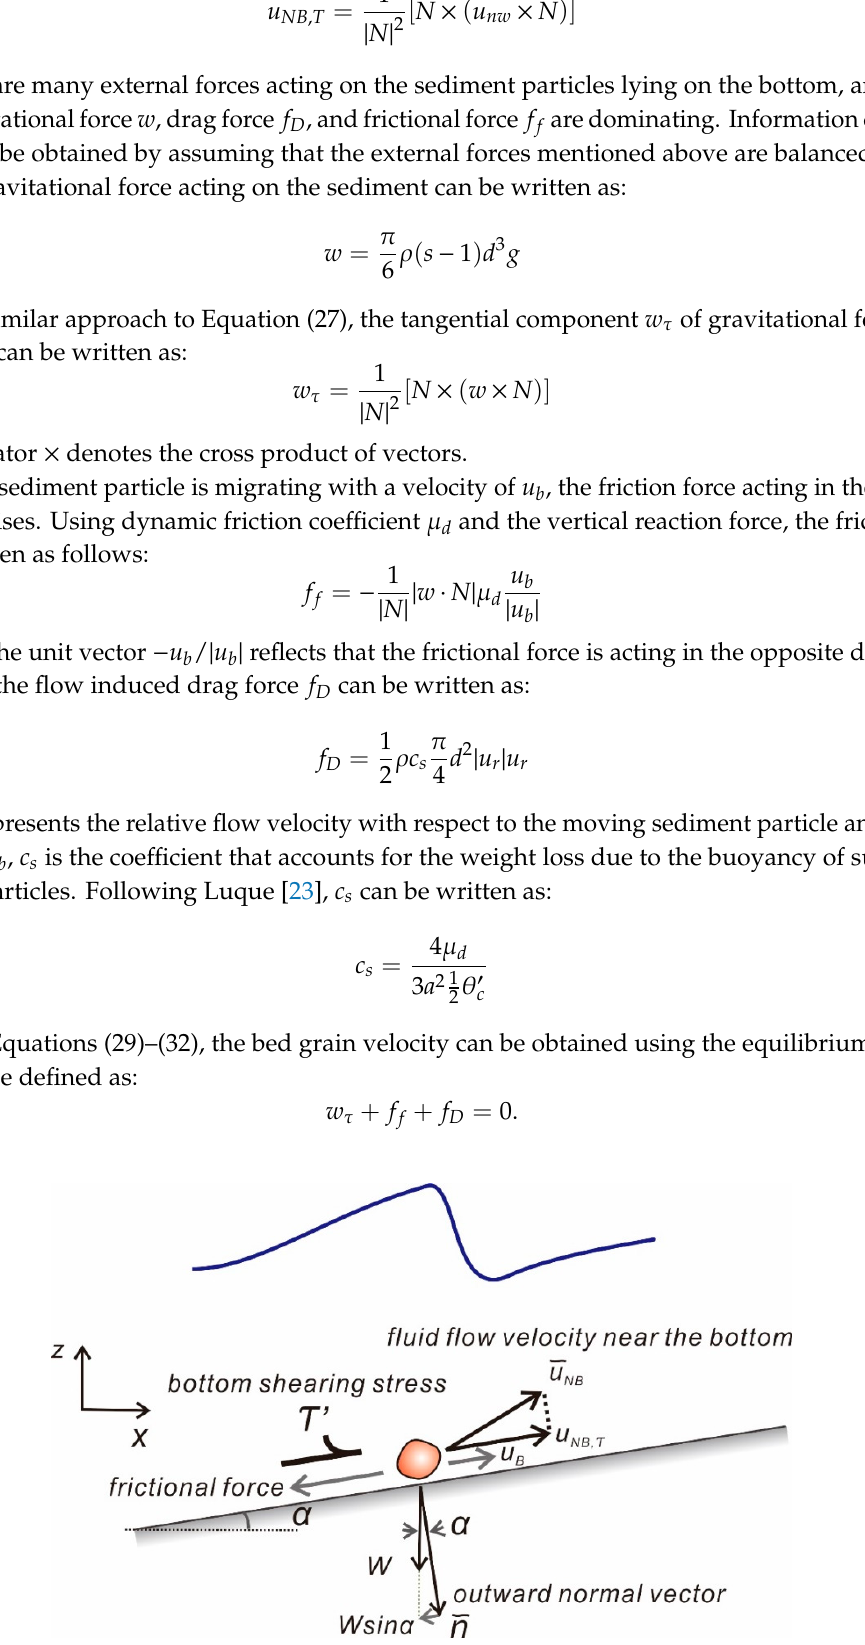
α . Figure 3. Free body diagram of the sand particles resting at the sea bottom of slope α